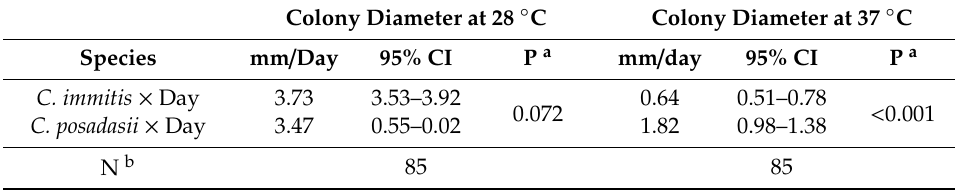
Figure 1. Temperature impacts growth ability of C. immitis isolates compared to C. posadasii on YE media. Seven mm diameter plugs were sub-cultured onto yeast extract plates and radial growth was documented over 16 days. ( A ) Radial growth measurements at 37 ◦ C for 46 C. posadasii and 39 C. immitis isolates in triplicate. ( B ) Radial growth measurements at 28 ◦ C for 46 C. posadasii and 39 C. immitis isolates in triplicate. ( C ) Representative of phenotypic variation observed for C. immitis on day 16. ( D ) Representative of phenotypic variation observed for C. posadasii on day 16. Table 2. Temperature Specific Linear Model Slope Estimates for Radial Growth Rate at 28 ◦ C or 37 ◦